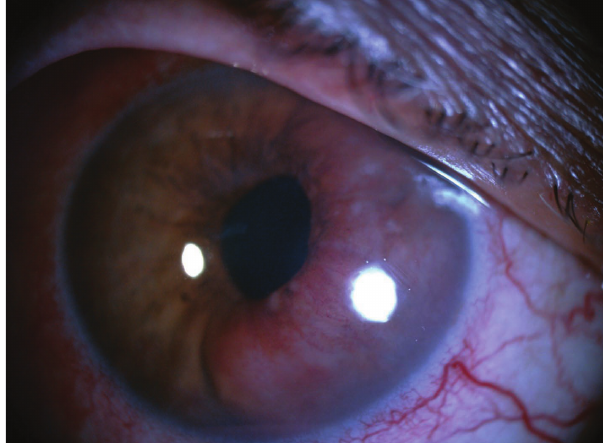
Figure 4. Enlarged vascularized iris mass, two weeks after first visit.